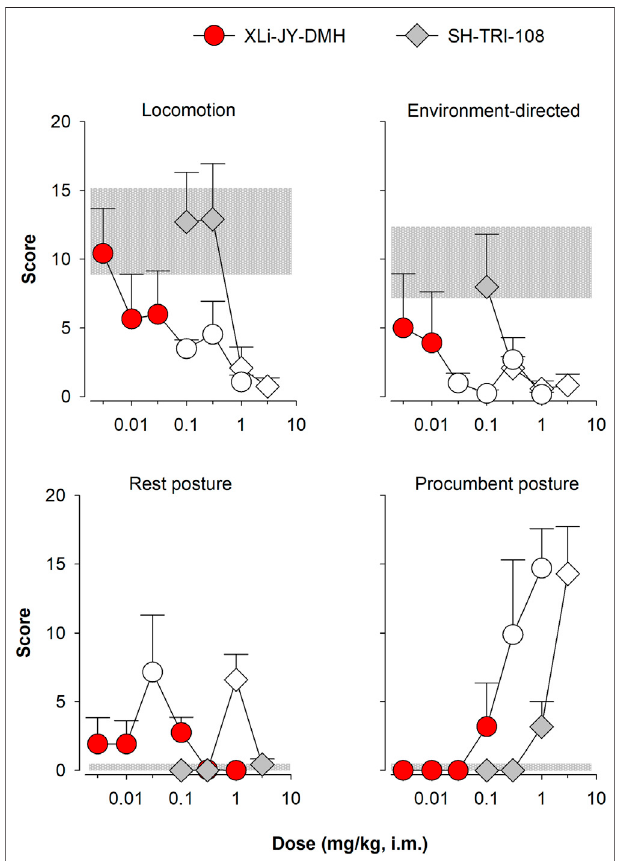
FIGURE 4 | Observable behavior following i. m. injections of XLi-JY- DMH and SH-TRI-108 in squirrel monkeys (N (cid:1) 4). Data are mean modi fi ed frequency score (+/- SEM) for four behaviors altered signi fi cantly by treatments (see Table 1 for de fi nitions). Symbols fi lled with white represent signi fi cant differences from vehicle, represented as gray horizontal bars (lower and upper SEMs), Fisher ’ s method.